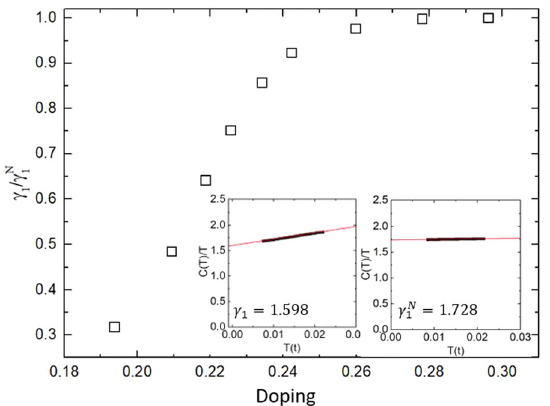
Fig. 7 Doping dependence of speci fi c heat coef fi cient γ 1 normal- ized by the corresponding normal-state value γ 1N . The zero- temperature speci fi c heat coef fi cient is extracted by fi tting C ( T )/ T using C ( T )/ T = γ 1 + γ 2 T and extrapolating to T = 0. The fi tting is illustrated in the inset, where the left panel is for the d -wave SC state while the right corresponds to the normal